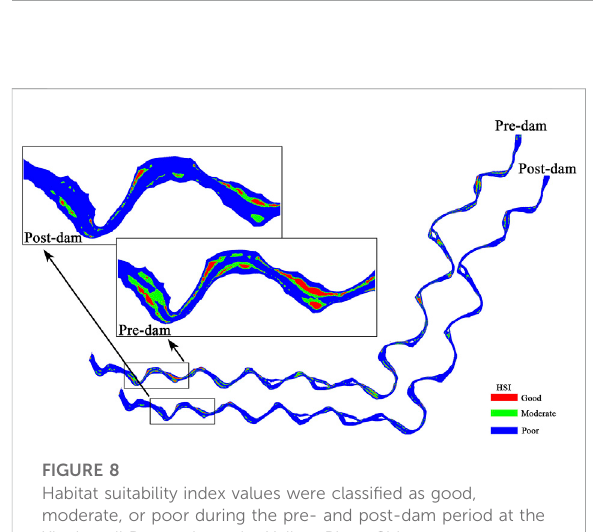
FIGURE 8 Habitat suitability index values were classi fi ed as good, moderate, or poor during the pre- and post-dam period at the Xiaolangdi Reservoir on the Yellow River, China.